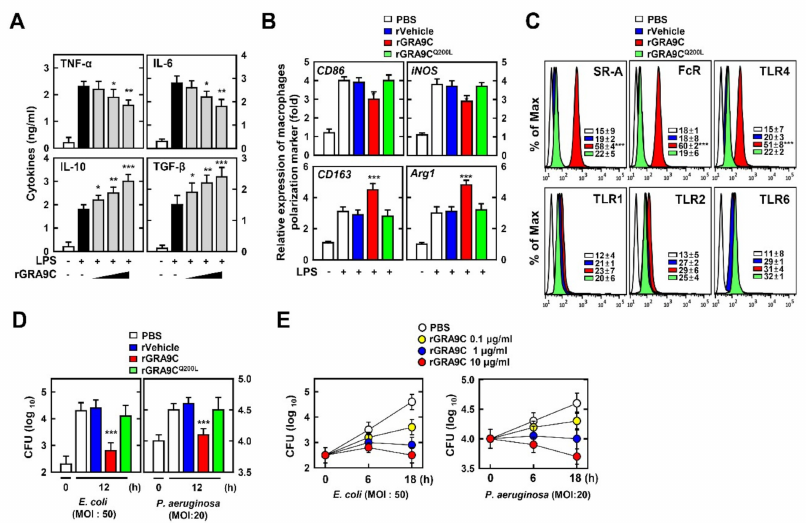
Figure 5. rGRA9C enhances anti-inflammation and bactericidal e ff ect via M1 to M2